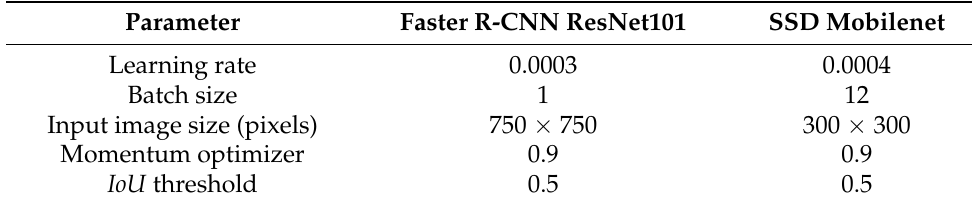
Table 1. Training parameters used for each of the models.